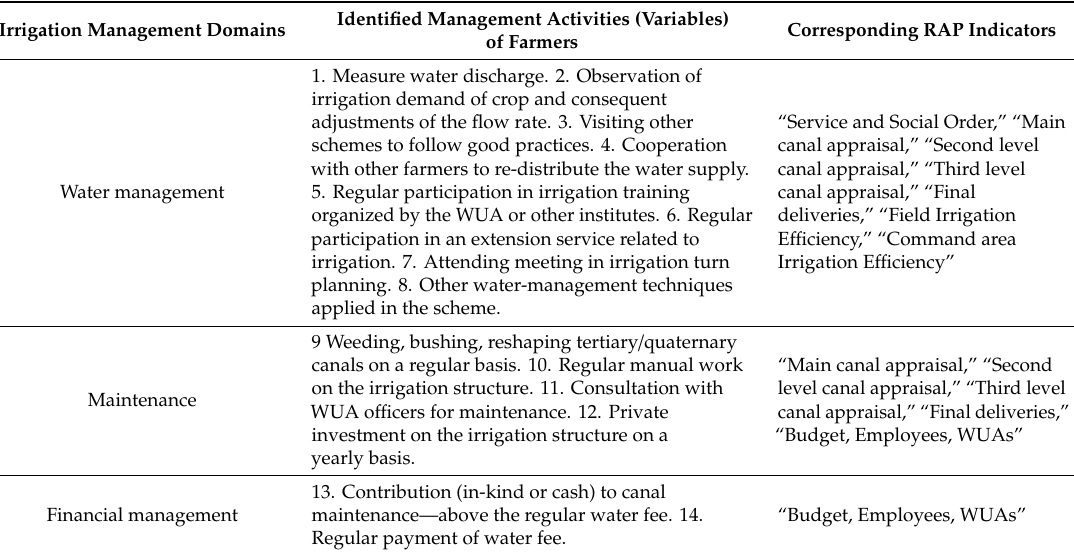
Table 1. Identified management activities based on the RAP method.